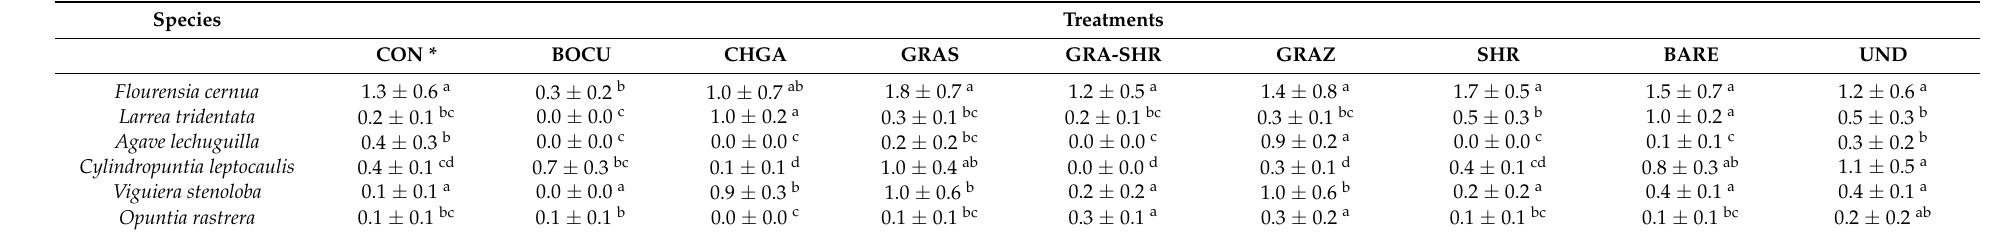
Table 2. Density of main species in sites of a microphyllous desert shrubland subjected to different transformations including seeding of perennial native or introduced grasses. Plant density was registered four years after treatments were imposed. Values are means ± standard